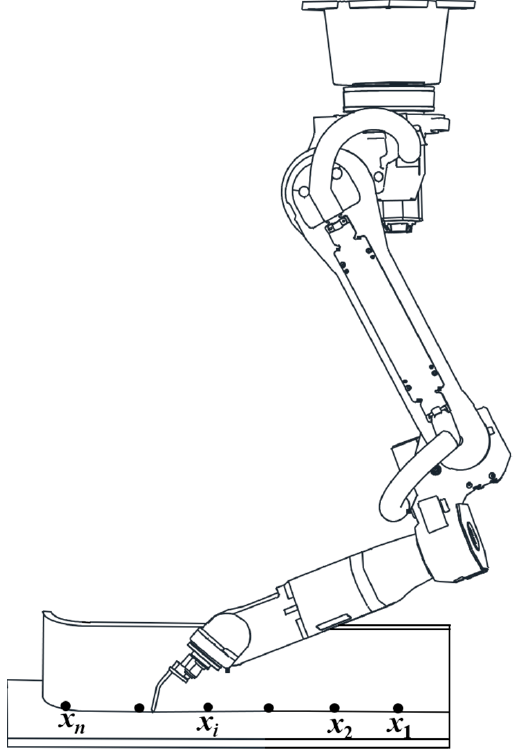
Figure 2. Three-dimensional welding model of the arc weld seam.